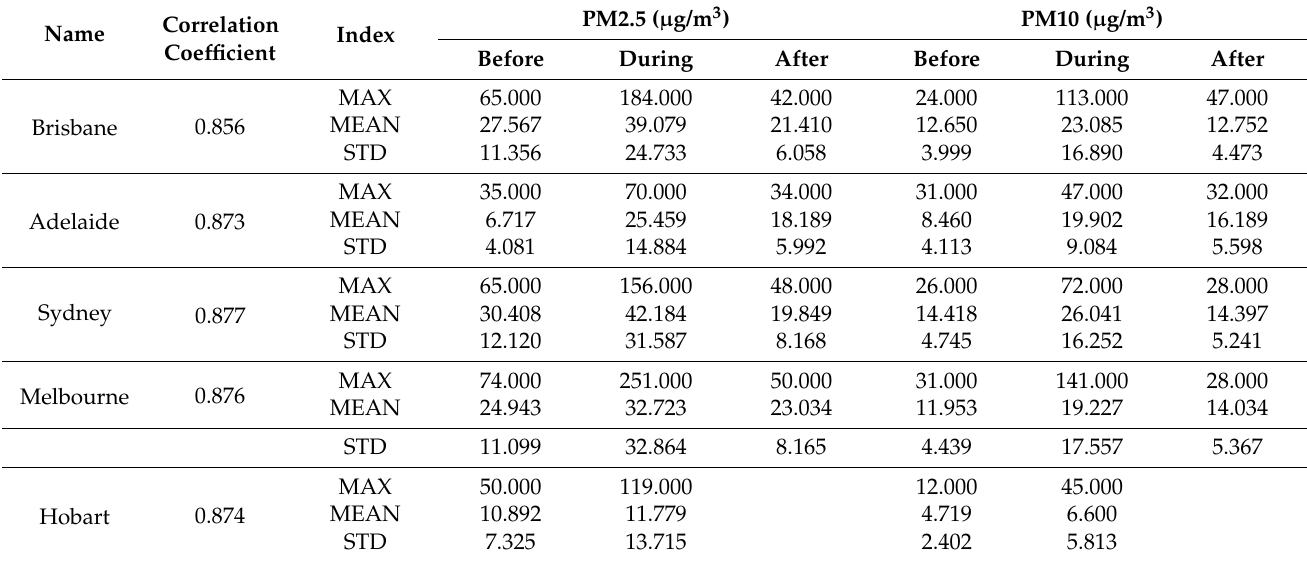
Table 3. Correlation coefficient between particulate matter 2.5 (PM2.5) and particulate matter 10 (PM10) and index statistics of PM2.5/PM10 before, during, and after forest fire.